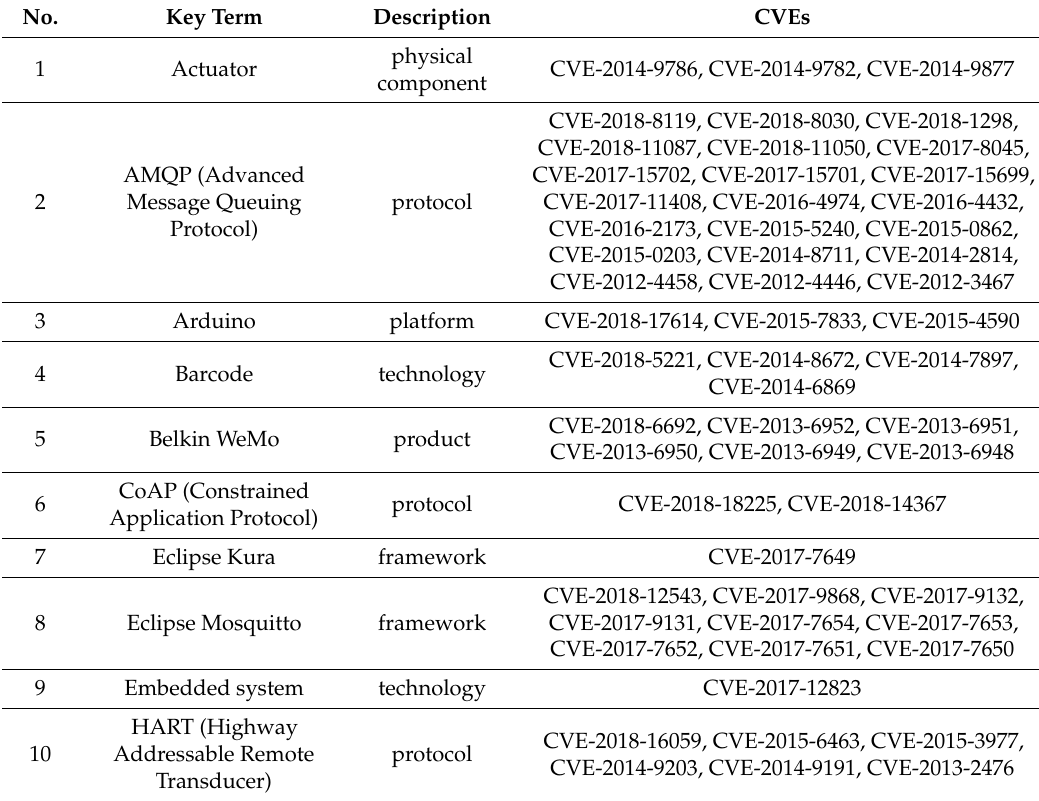
Table 1. A subset of the common vulnerabilities and exposures (CVEs) relevant for the Internet of Things (IoT)